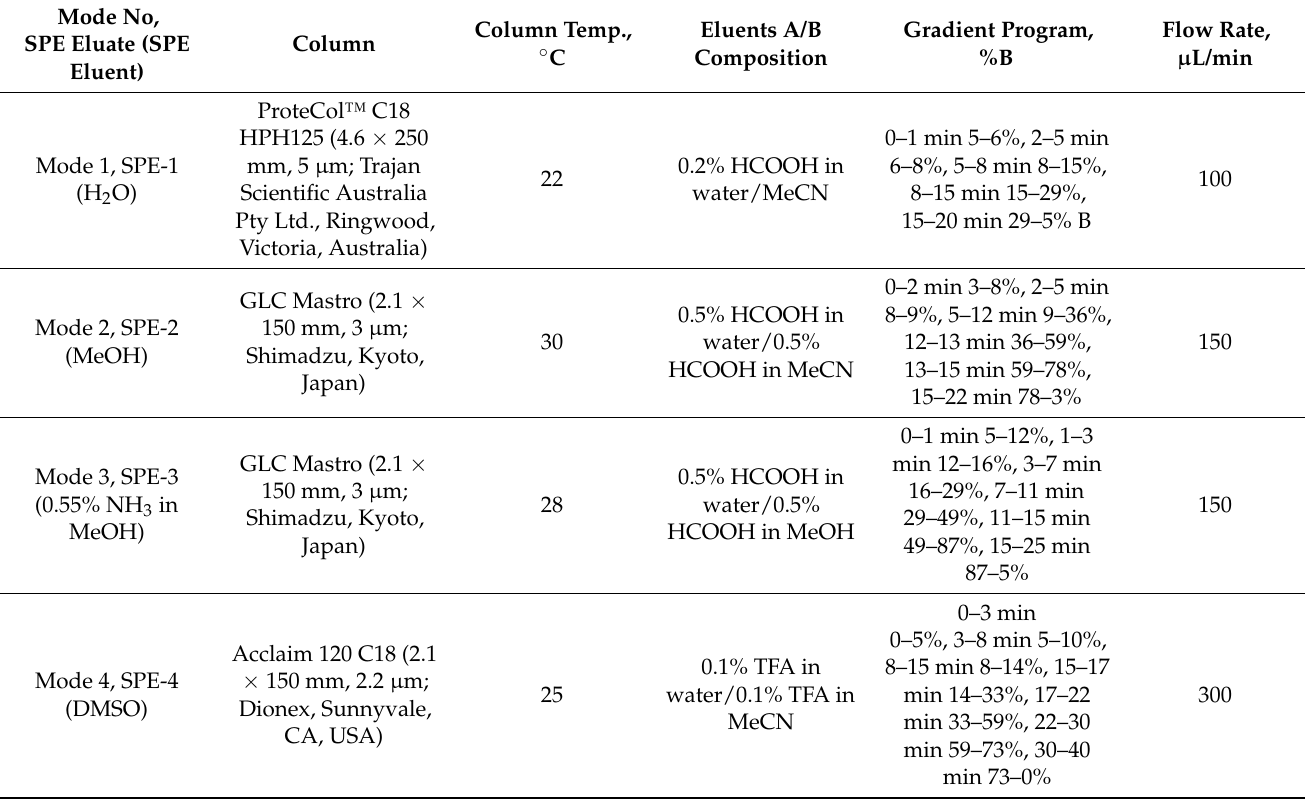
Table 1. HPLC conditions used for metabolite